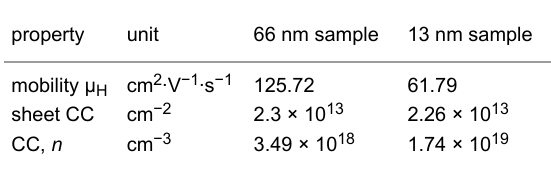
Table 1: Hall effect data of 66 nm and 13 nm MLD-doped SOI.